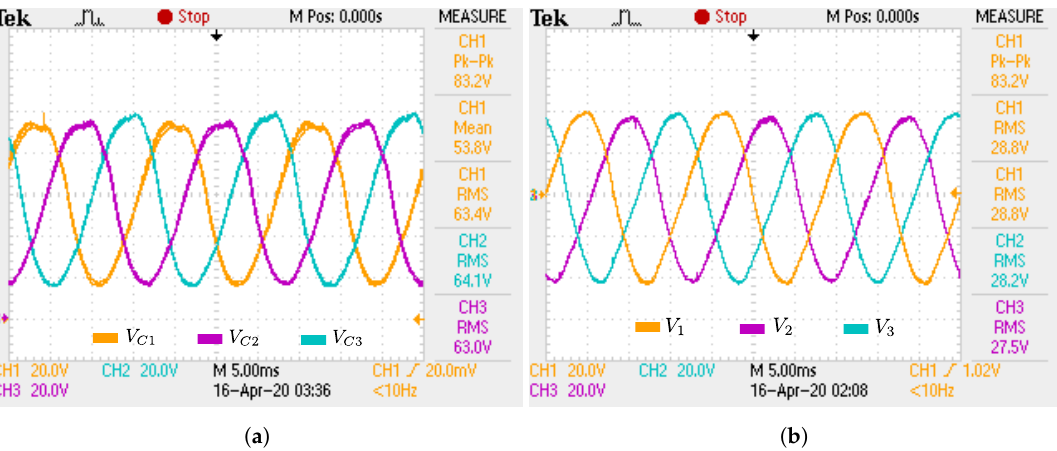
Figure 30. Experimental waveforms of capacitor and load phase voltages for RC load case: ( a ) Capacitor voltages; ( b ) Load phase voltages.